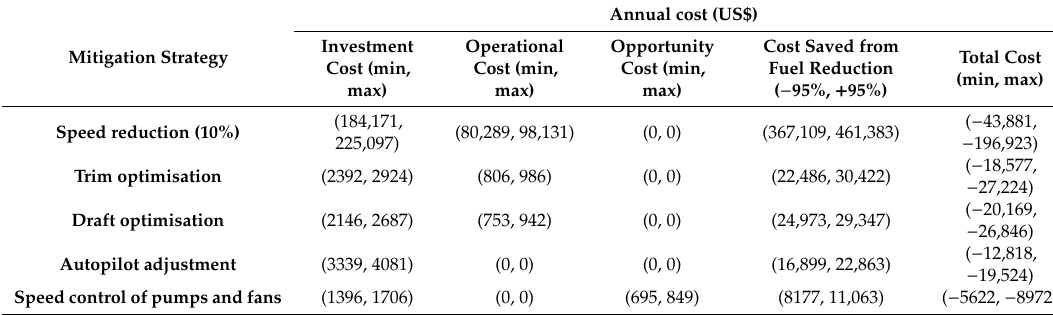
Table 5. Costs for di ff erent mitigation